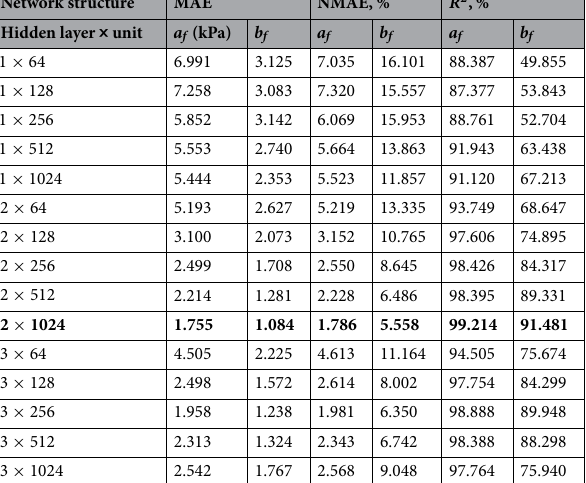
Table 2. Averaged MAE, NMAE, and R 2 scores for two properties a f and b f with respect to network structure in ten-fold cross-validation (2000 epochs). The 2 × 1024 structure had the best prediction and was used in the ML model.